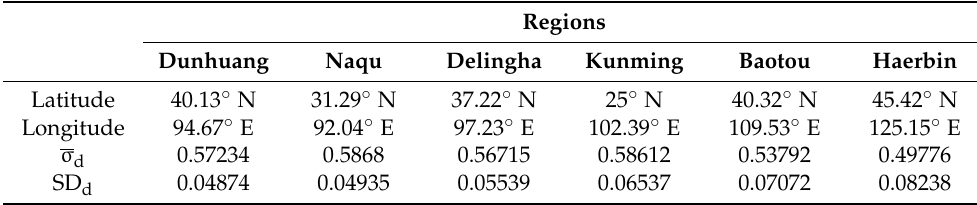
Table 2. Latitude and longitude and the daily average effective tracking factor σ d and SD d of SDC systems in different